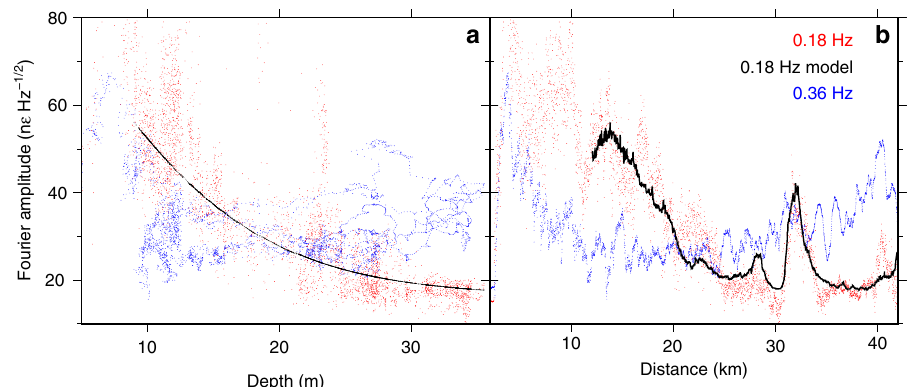
Fig. 6 Depth and distance scaling. a Fourier components of the raw distributed acoustic sensing strain spectrum at 0.18 (primary microseism, red) and 0.36 Hz (secondary microseism, blue) calculated at each channel plotted versus water depth. Also shown is the model of 0.18-Hz noise as a function of theoretical sea fl oor pressure described in the text (black). b Same as a but plotted with distance along the fi ber.